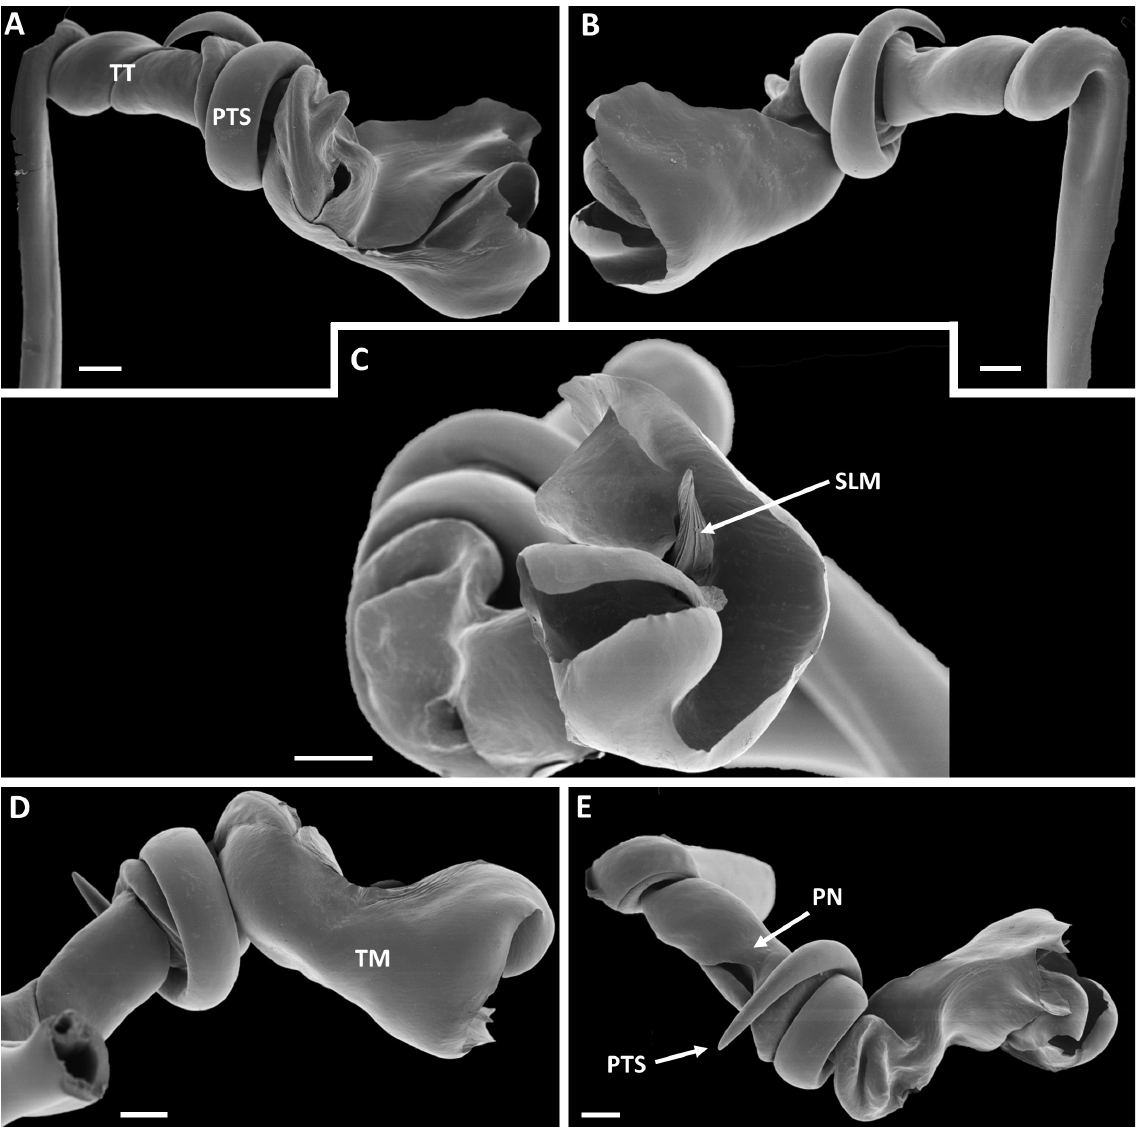
Fig. 16. Calyptomastix ingemanni sp. nov., holotype, ♂ (NHMD 621715), right gonopod telopodite. A . Posterior view. B . Anterior view. C . (Sub)mesal view. D . Basal (dorsal) view. E . Apical (ventral) view. Abbreviations: PN = post-torsal narrowing; PTS = post-torsal spine; SLM = solenomere; TM = telomere; TT = torsotope. Scale bars = 0.1